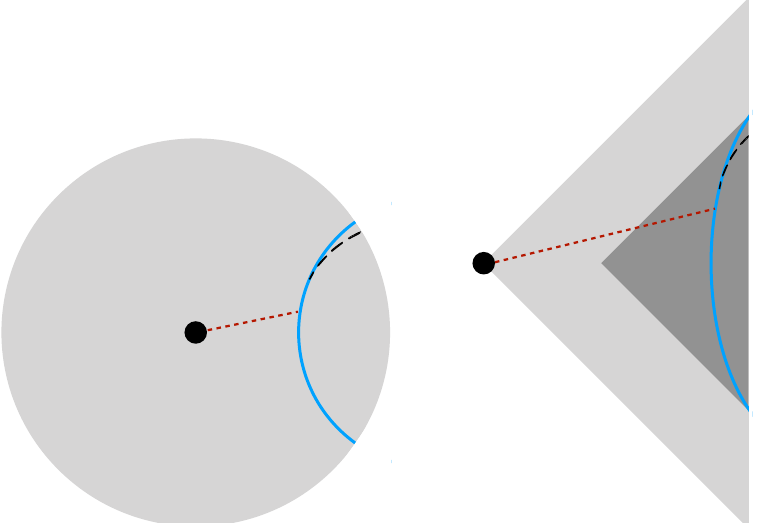
Figure 6 . Summary of our quantitative match. We consider the length of the a 1-sided black hole (with an end of the world brane), potentially with a kick dictated by SL(2) charge conservation. This matches the complexity as calculated in the toy model. The change in trajectory is due to the additional angular momentum when a perturbation to the particle is applied. The length of the dashed red lines in both (cid:12)gures are to be